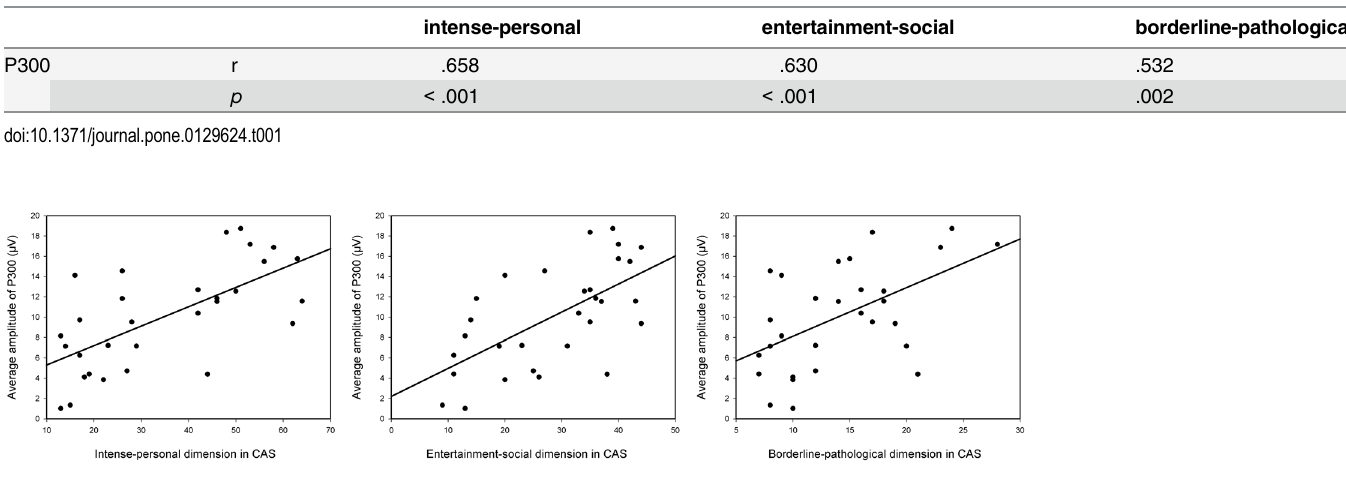
Fig 3. Corrections between the three dimensions in the CAS scale and average amplitude of